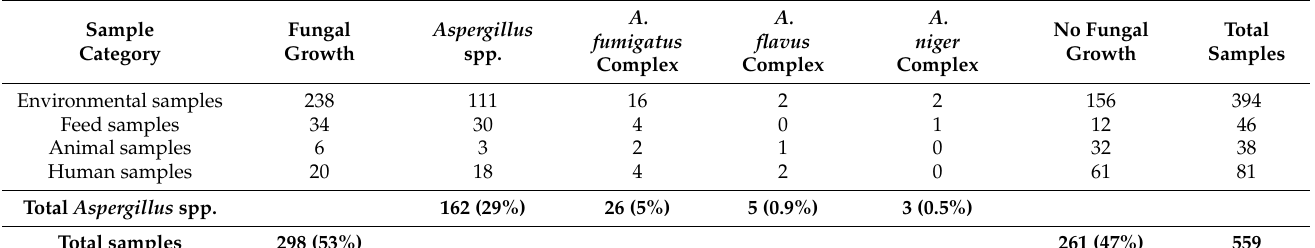
Table 2. Results of mycological examination.